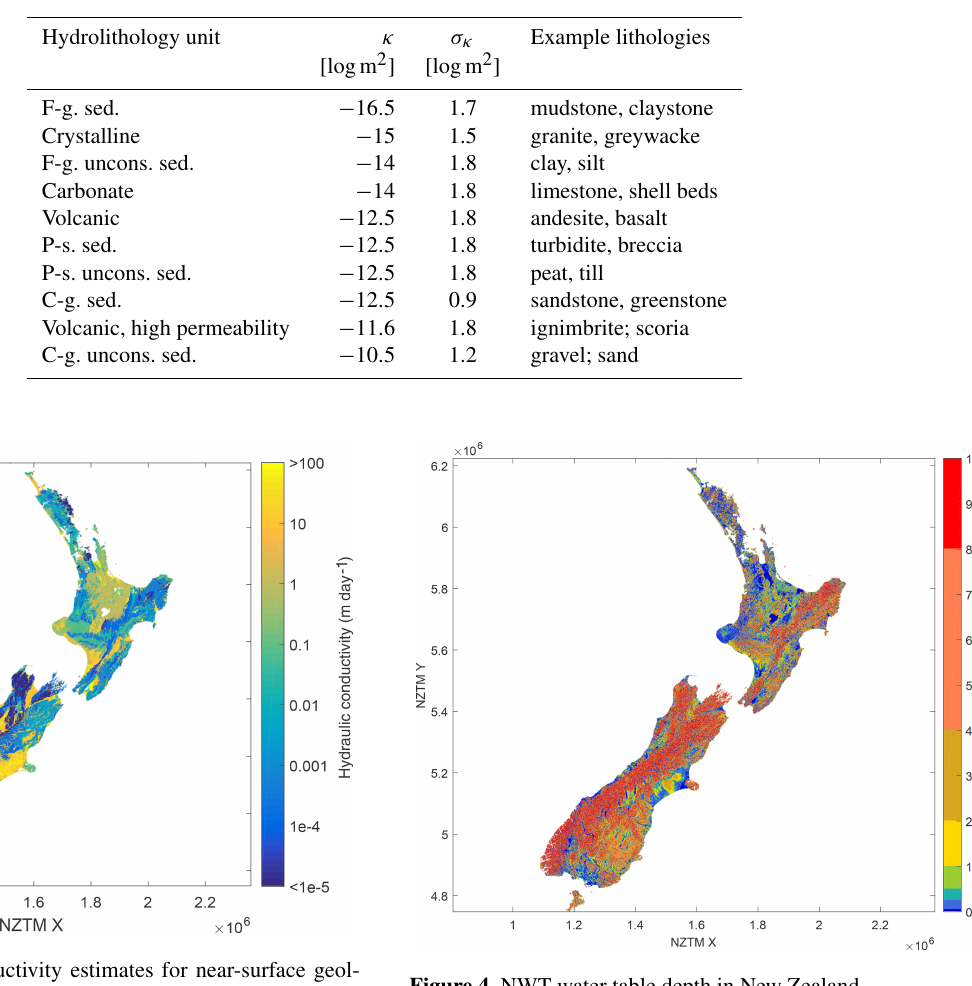
Table 1. New Zealand hydrolithologies and their intrinsic permeability κ , including standard deviation σ κ , after Gleeson et al. (2011) and Tschritter et al. (2016). F-g. stands for fine-grained, p-s. for poorly sorted, c-g. for coarse-grained, uncons. for unconsolidated, and sed. for sediment.